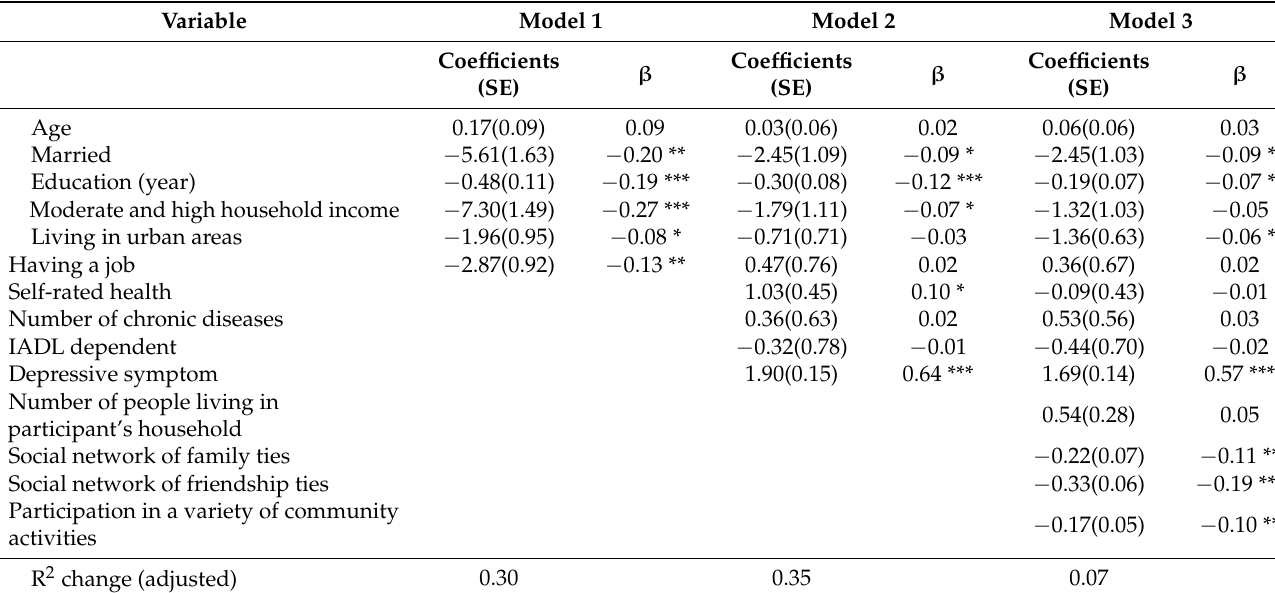
Table 3. Multivariate hierarchical regression model predicting loneliness for